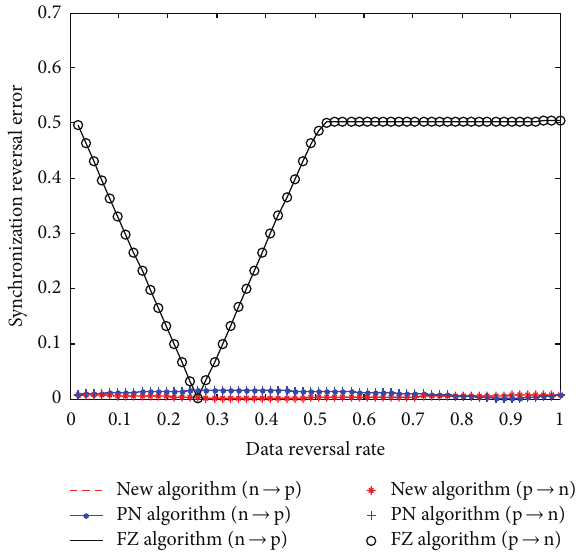
Figure 10: The estimated reversal errors compared with changing